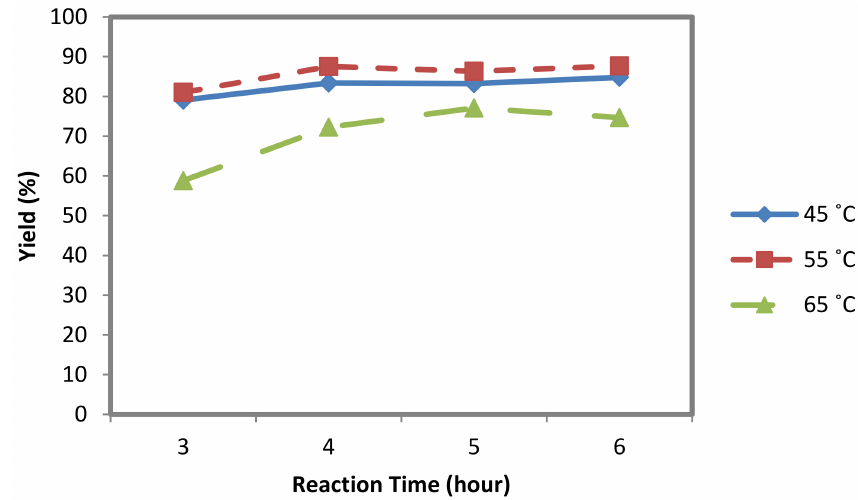
Figure 2. Influence of reaction temperature on the yield (methanol to oil molar ratio 12:1, catalyst loading 4 wt.%, stirring rate 700 rpm, reaction time 3–6 h).